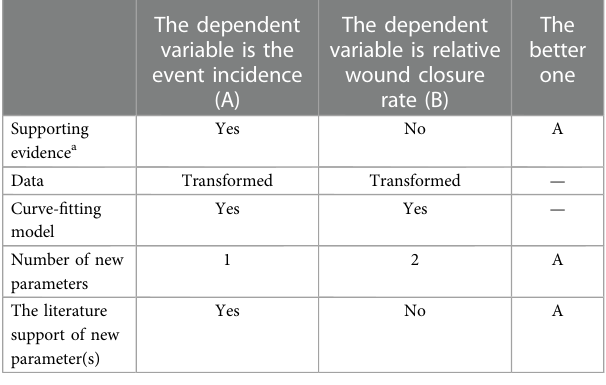
TABLE 4 Selection of the dependent variable in dose – response curves.